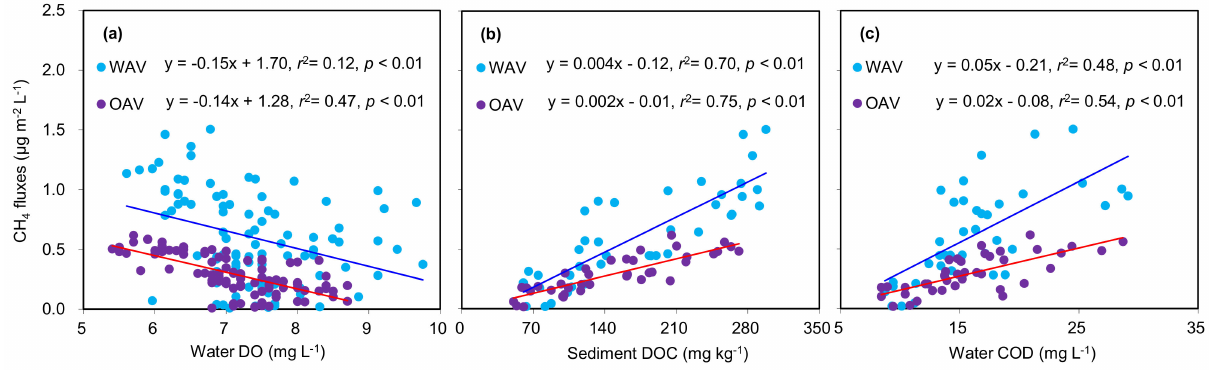
Figure 4. Dependence of CH 4 fluxes on water and sediment parameters in the waterlogging fresh- water crayfish–fish aquaculture ponds. ( a ) Dissolved oxygen (DO) in water; ( b ) dissolved organic carbon (DOC) in sediment; ( c ) water chemical oxygen demand